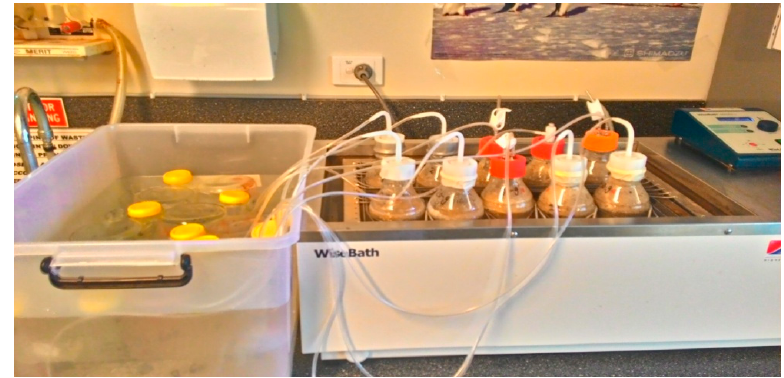
Figure 2. Bagasse fermentation and collection of CO 2 gas equipment.